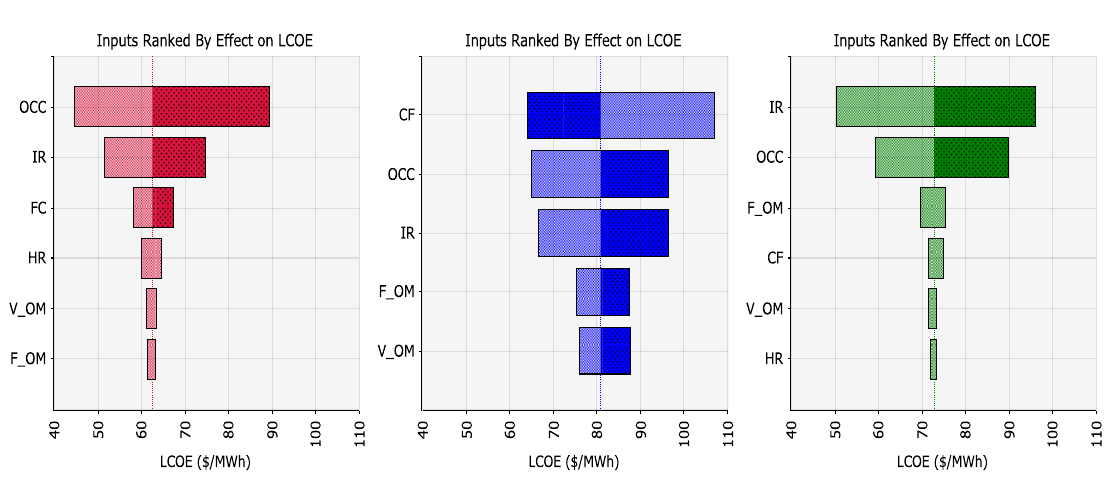
Figure 6. LCOE tornado diagrams of Coal, Wind, and Nuclear.